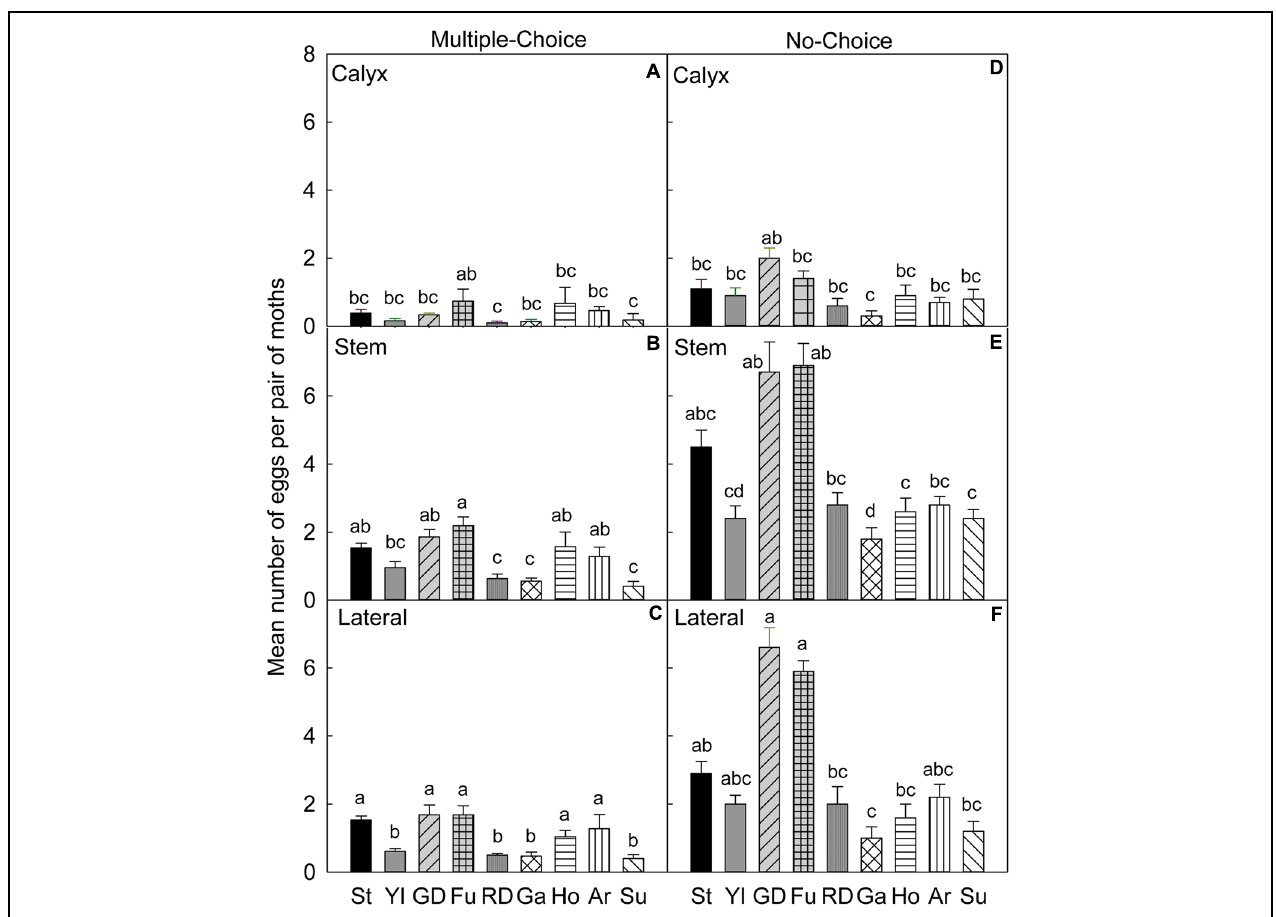
FIGURE 2 | Relative susceptibility of different apple cultivars for oviposition of codling moth during August 2006 (late season/Set 2). Mean number of eggs per pair of moths per fruit on calyx, stem, and lateral sides of fruits of different cultivars are shown in multiple-choice tests (A–C) and no-choice tests (D–F) .St, Stayman; YI, York Imperial; GD, Golden Delicious; Fu, Fuji; RD, Delicious; Ho, Honeycrisp; Ar, Arlet; Su, Sunrise; Ga, Gala. N = 8 for all the multiple-choice tests, and N = 10 for all the no-choice tests. Each bar represents standard error of mean. Different letters over bars indicate significant difference ( P < 0.05).